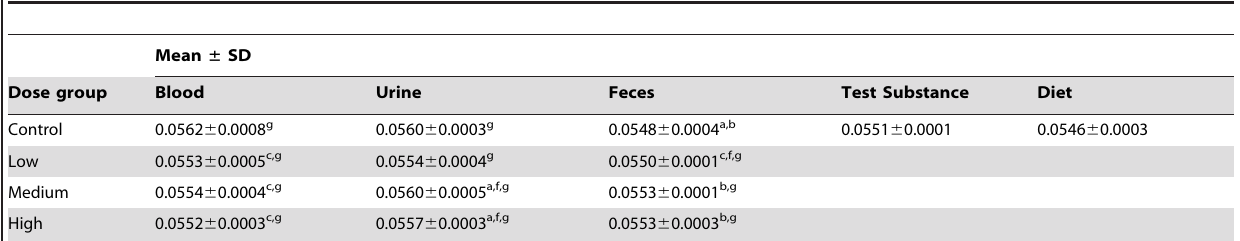
Table 2. Statistical significance of differences in 204 Pb/ 206 Pb for test substance, diet, blood, urine, and feces in different dose groups (n= 6) of respiratory lead exposure.